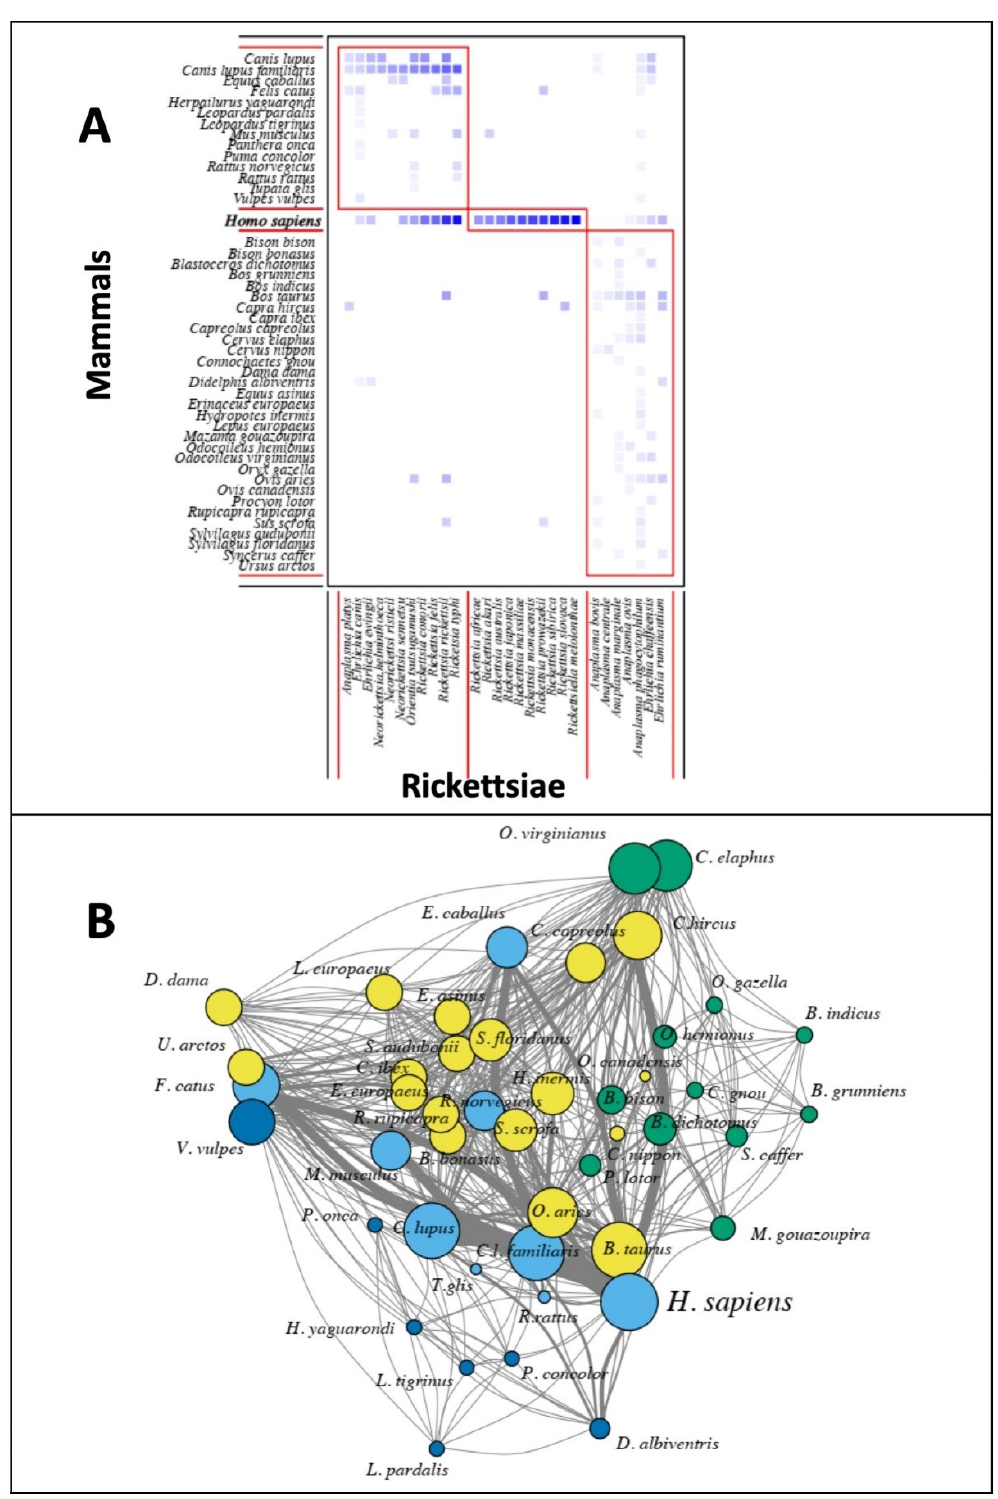
Figure 5. Composite panels of modules identified using ( A ) bipartite network and ( B ) subgroups identified by unipartite network subgroups (di ff erentiated by colors) of shared rickettsial species among mammal species and humans. The links among nodes (node = species) of the unipartite network depict shared rickettsial species / mammals and humans (vertices were placed according to the Fruchterman–Reingold algorithm) with thickness of links proportional to number of rickettsial species shared and size of vertices proportional to the degree centrality of carriers (nodes). List of mammal species is given in Figure 2. Data were extracted from the EID2 database